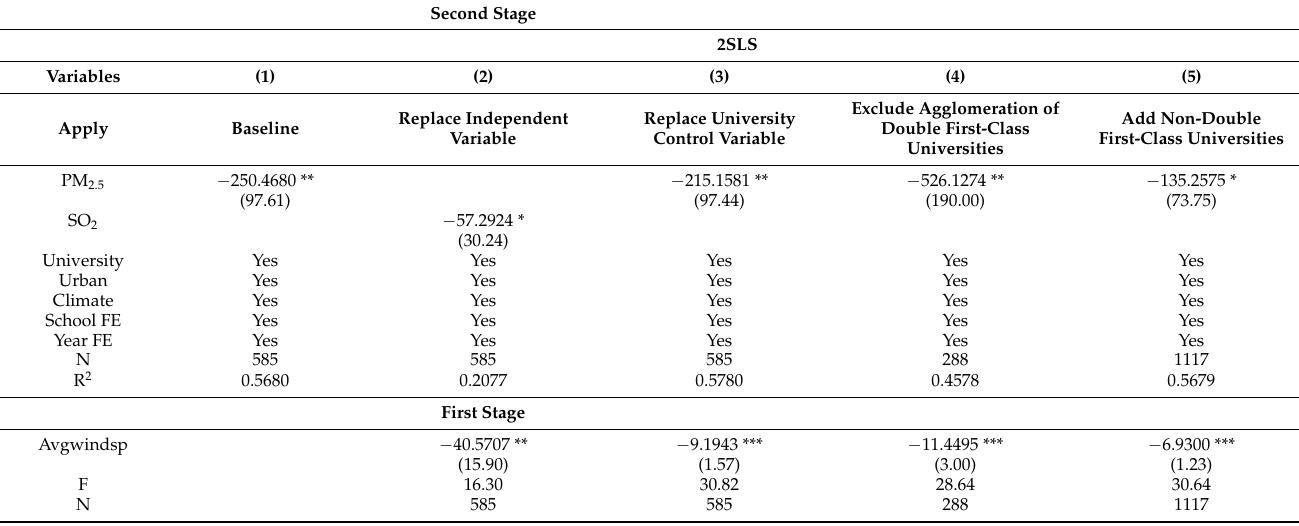
Table 5. Robustness check